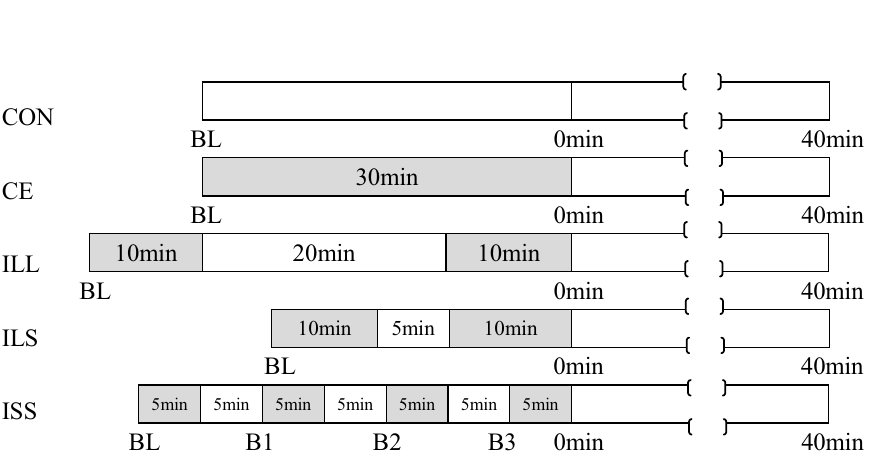
Table 1. Subject characteristics (n = 20). Values are means ± SE. BMI body mass index, BP blood pressure.